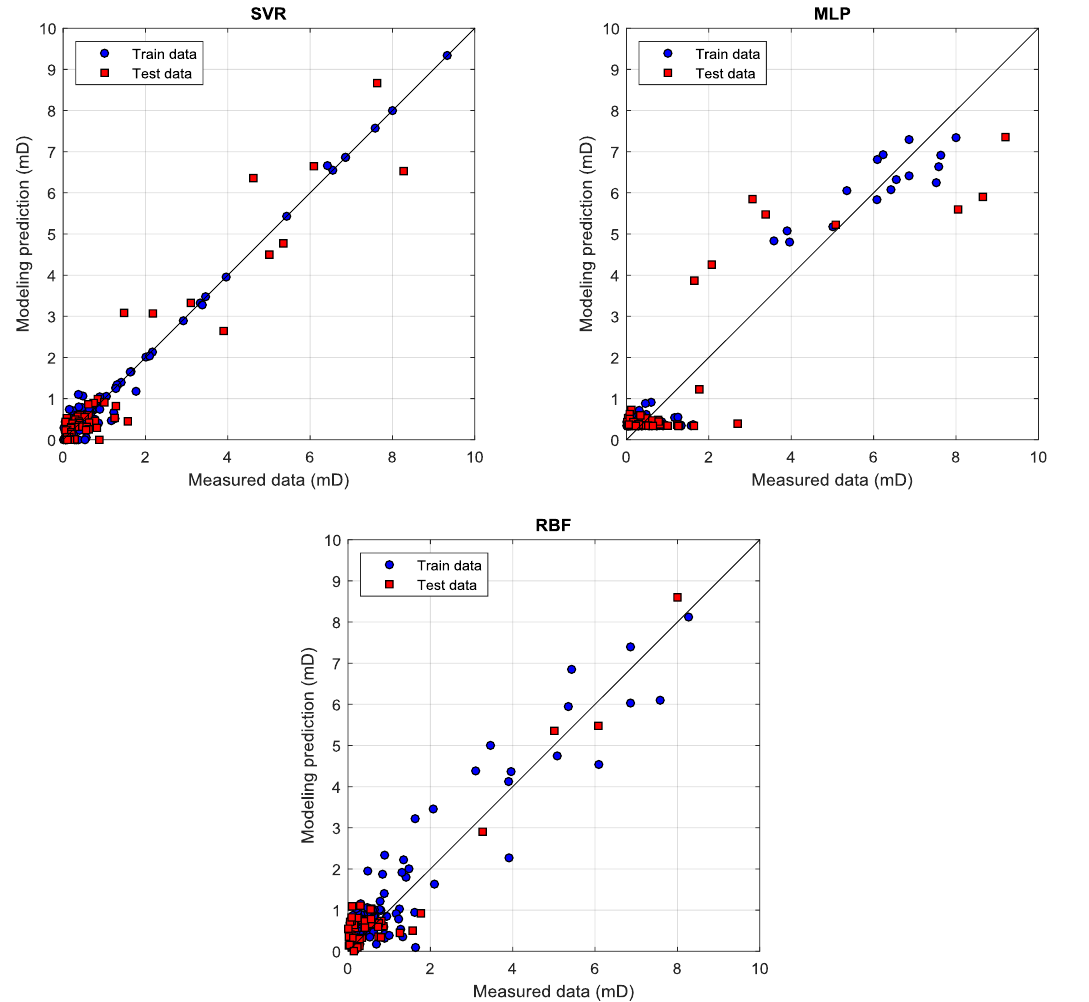
Figure 10. The cross plot of modeling prediction of permeability versus measured data for both train and test data Moreover, Figure 11 illustrates the relative deviations of these models. In other words, these plots show the dispersion between data and outputs of constructed models. These variations can be distinguished in different ranges of data (horizontal axes). As illustrated in Figure 11, the applied SVM model shows the lowest data scattering and more concentrated